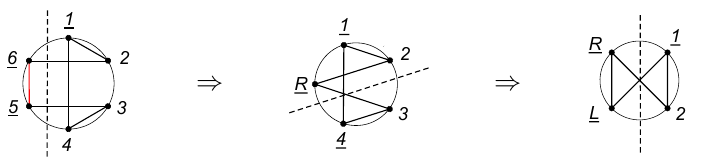
Figure 25 . Five and four-point integrands obtained from the second factorization contribution of I (2)